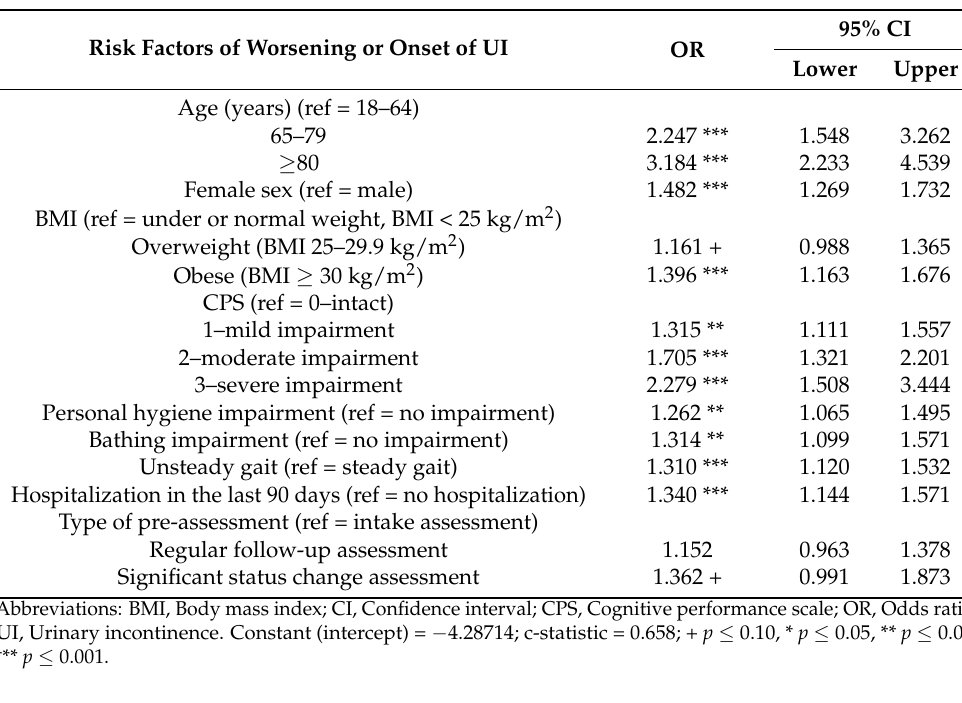
Table 3. Adjusted Odds Ratios for worsening or onset of urinary incontinence ( n = 8943 clients).